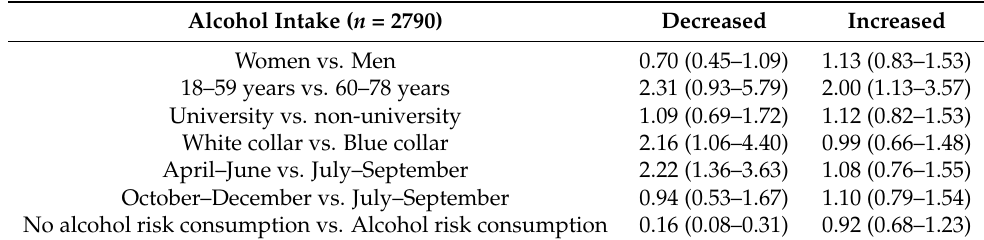
Table A2. Odds ratio (95% CI) for change (no change as reference) in alcohol intake in relation to